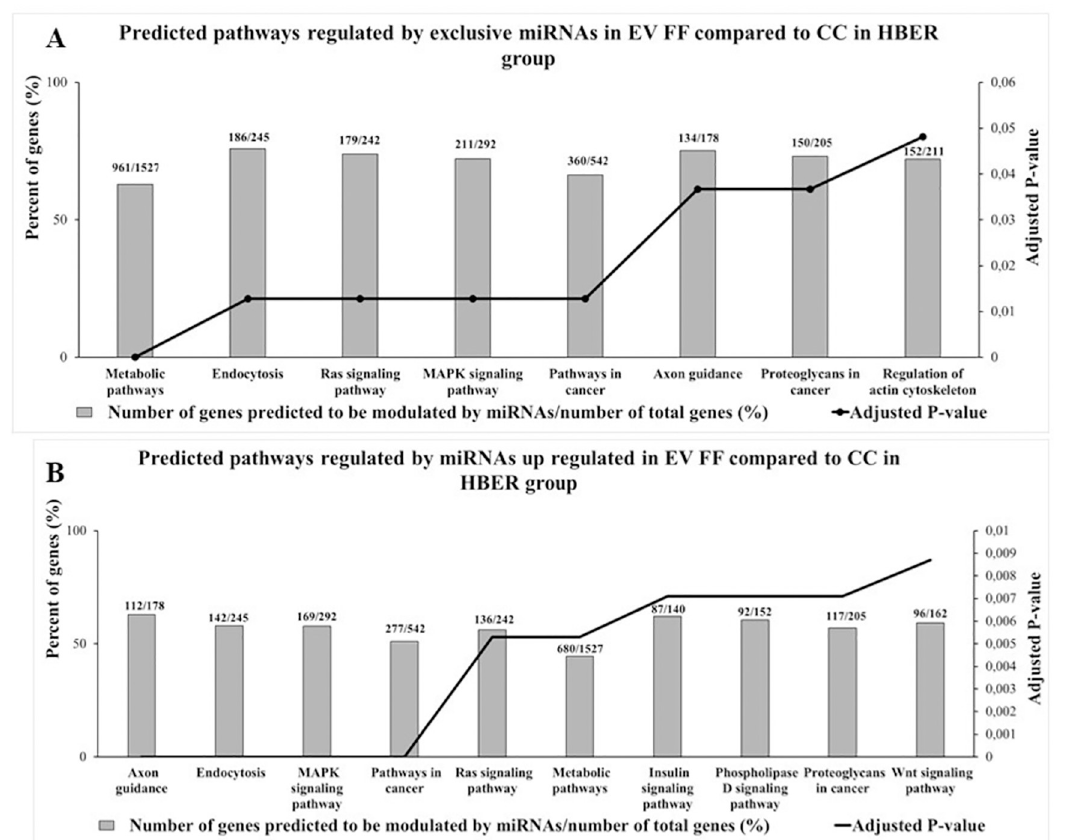
Fig 7. Enrichment analysis performed in miRWalk 3.0 software of predicted pathways modulated by exclusives or up- regulated miRNAs of cumulus cells (CC) and follicular fluid extracellular vesicles (EV FF) from 3–6 mm follicles from cows with high body energy reserve (HBER). A. The predicted pathways modulated by exclusives miRNAs in EV FF compared to CC in MBER group. B. The 10 predicted pathways with highest percent of genes predicted to be modulated by miRNAs up regulated in EV FF compared to CC in HBER group. The Y-axis in left represents the percent of genes (%) predicted to be modulated by miRNAs and the Y-axis in right shows the adjusted P -value (Adjusted P -value <